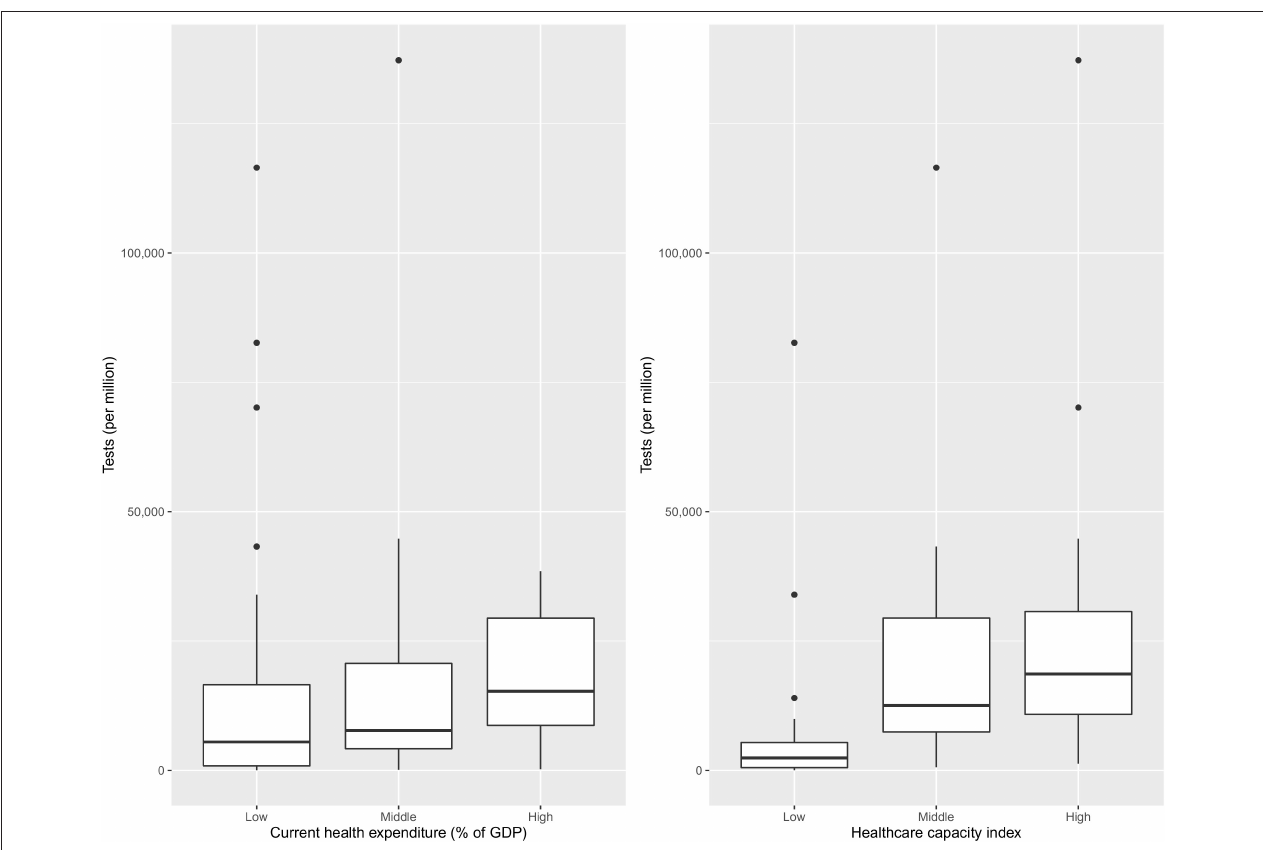
FIGURE 4 | Health expenditure and healthcare capacity group wise distribution of the number of tests per million ( n =